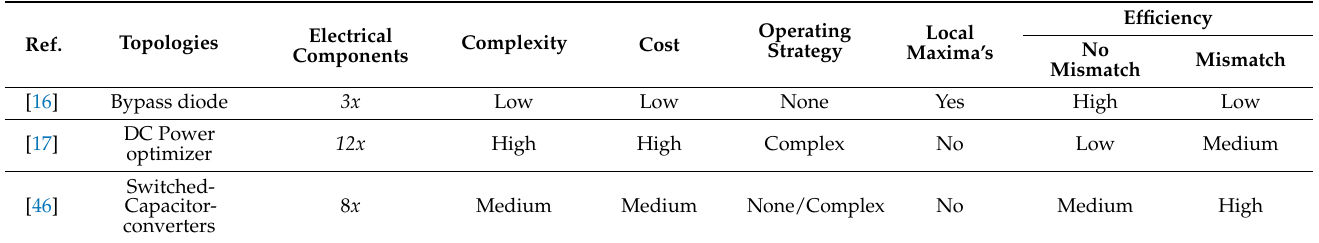
Figure 17. PV system outputs over a day under irradiance data on 1 September shown in Figure 13. Table 6. Evaluation of various mismatch reduction/mitigation methodologies for a PV module consisting of three sub-modules.